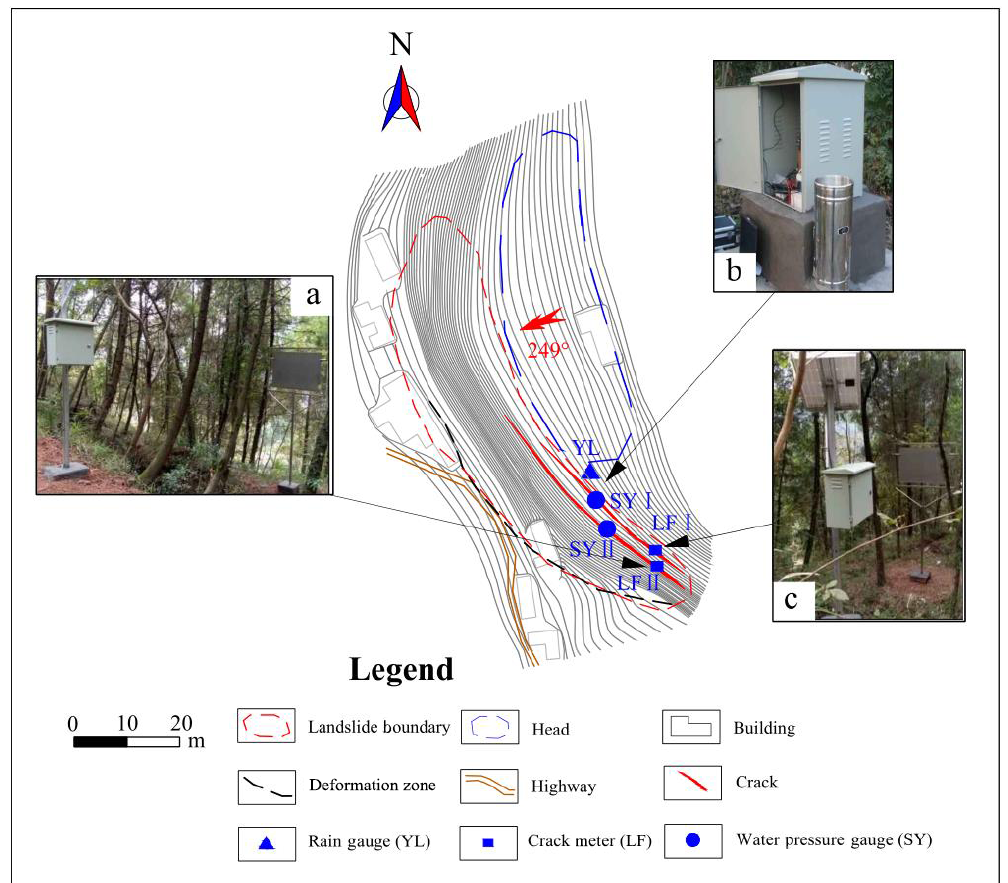
Figure 4. Location of the monitoring equipment: (a) crack II meter, (b) rain gauge and water pressure gauge, and (c) crack I meter.